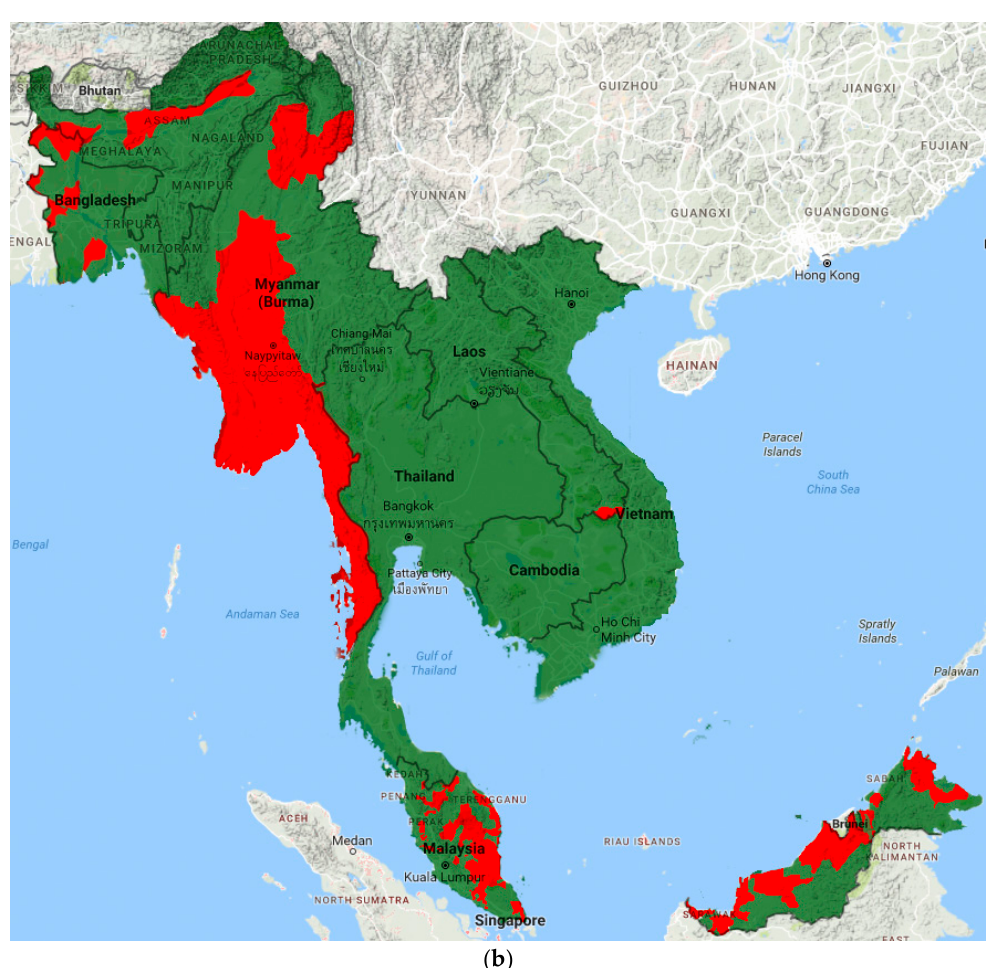
Figure 2. Distribution of LF endemic areas (red): ( a ) at baseline; and ( b ) based on most recent data.